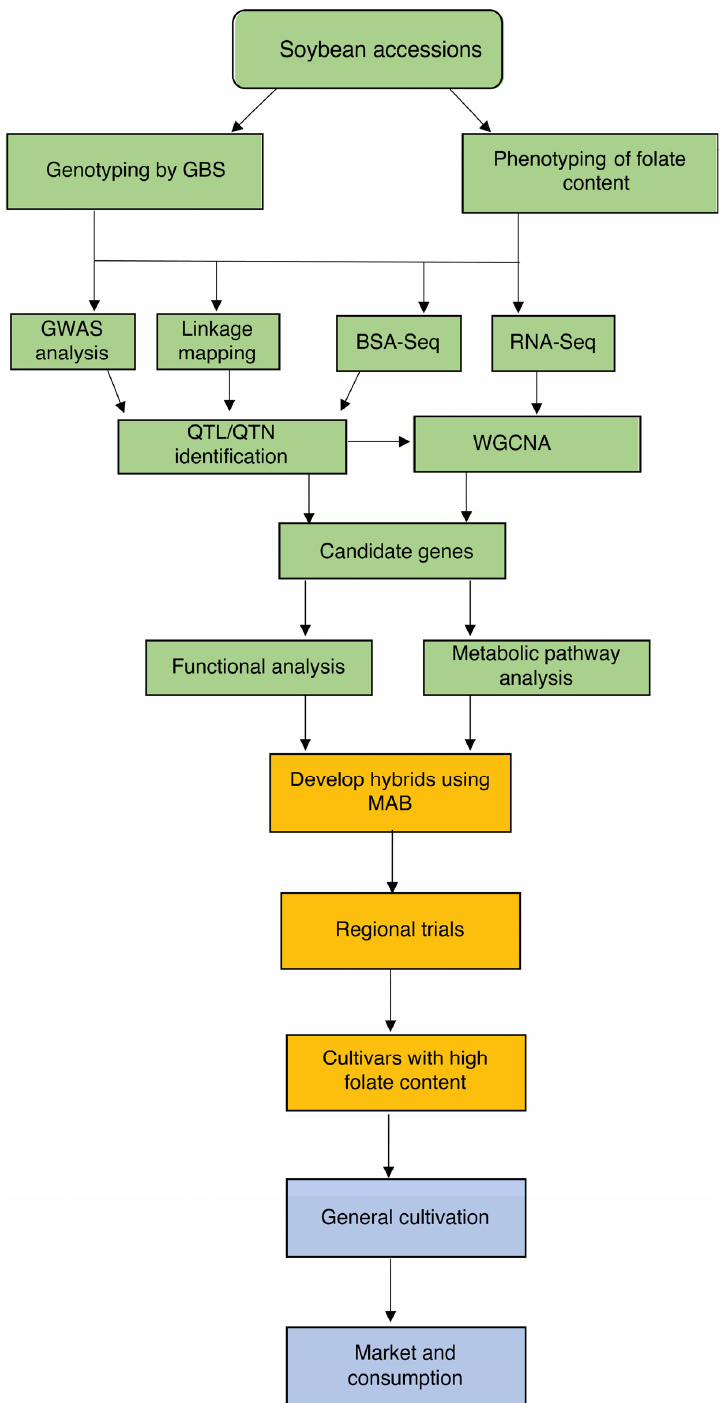
Figure 5. Framework for the genetic biofortification of folates in soybean. To improve the folate content of soybean, accessions can be genotyped using sequencing techniques, such as genotyping by sequencing (GBS) and phenotyped for their folate content. Linkage mapping, genome-wide association study (GWAS), and bulked-segregant analysis-sequencing (BSA-Seq) can be used to identify quantitative trait loci or quantitative trait nucleotides (QTL/QTN). The results from RNA-Seq can then be combined with QTL/QTN using weighted gene co-expression analysis (WGCNA) to identify candidate genes. These candidate genes can be further analysed for their functions and roles in the metabolic pathway. Finally, marker-assisted breeding (MAB) can be used to develop hybrids with improved folate